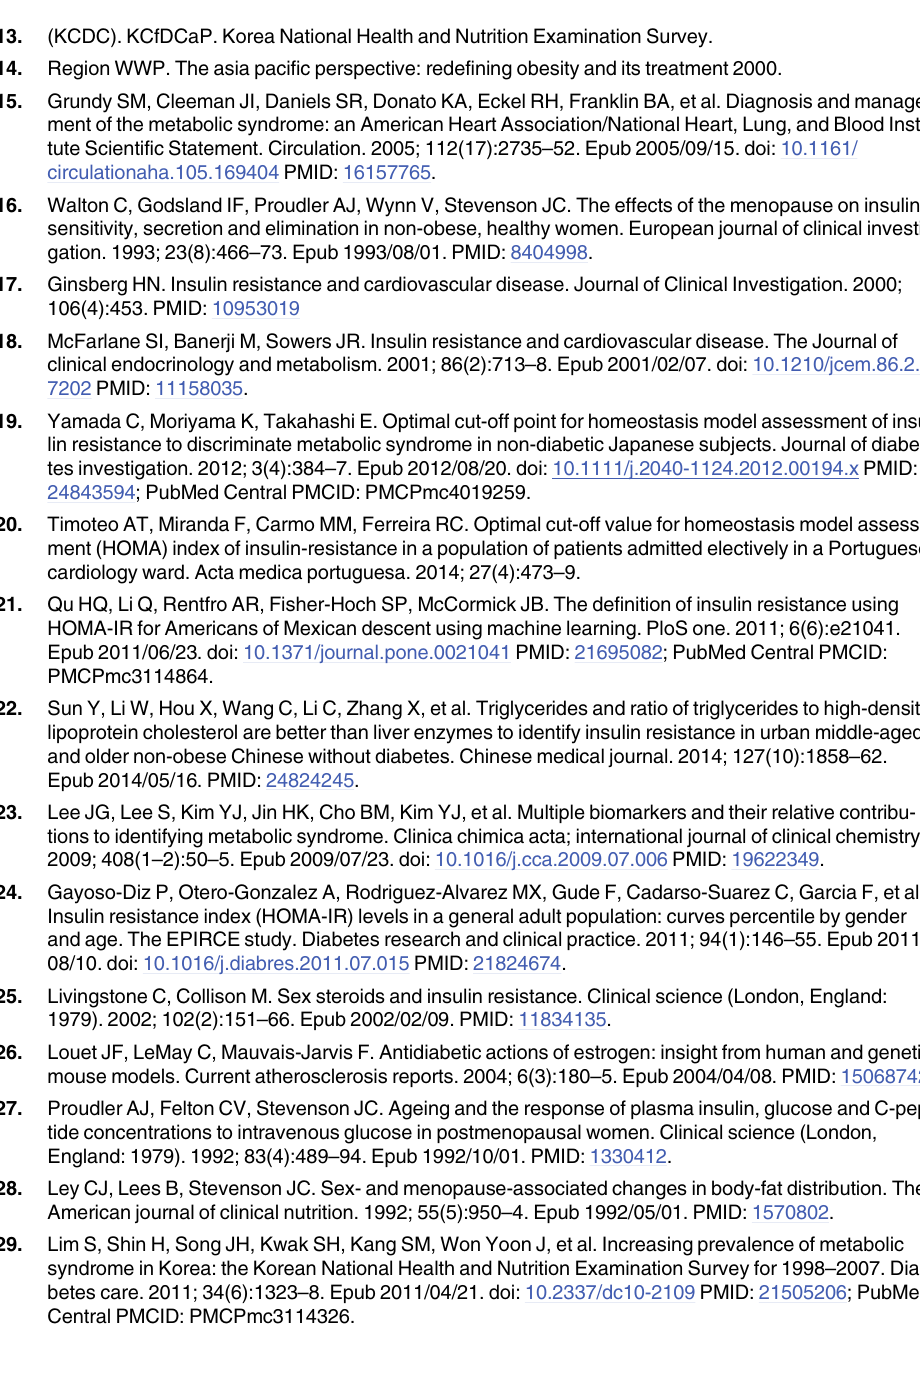
PLOS ONE | DOI:10.1371/journal.pone.0154593 April 29,